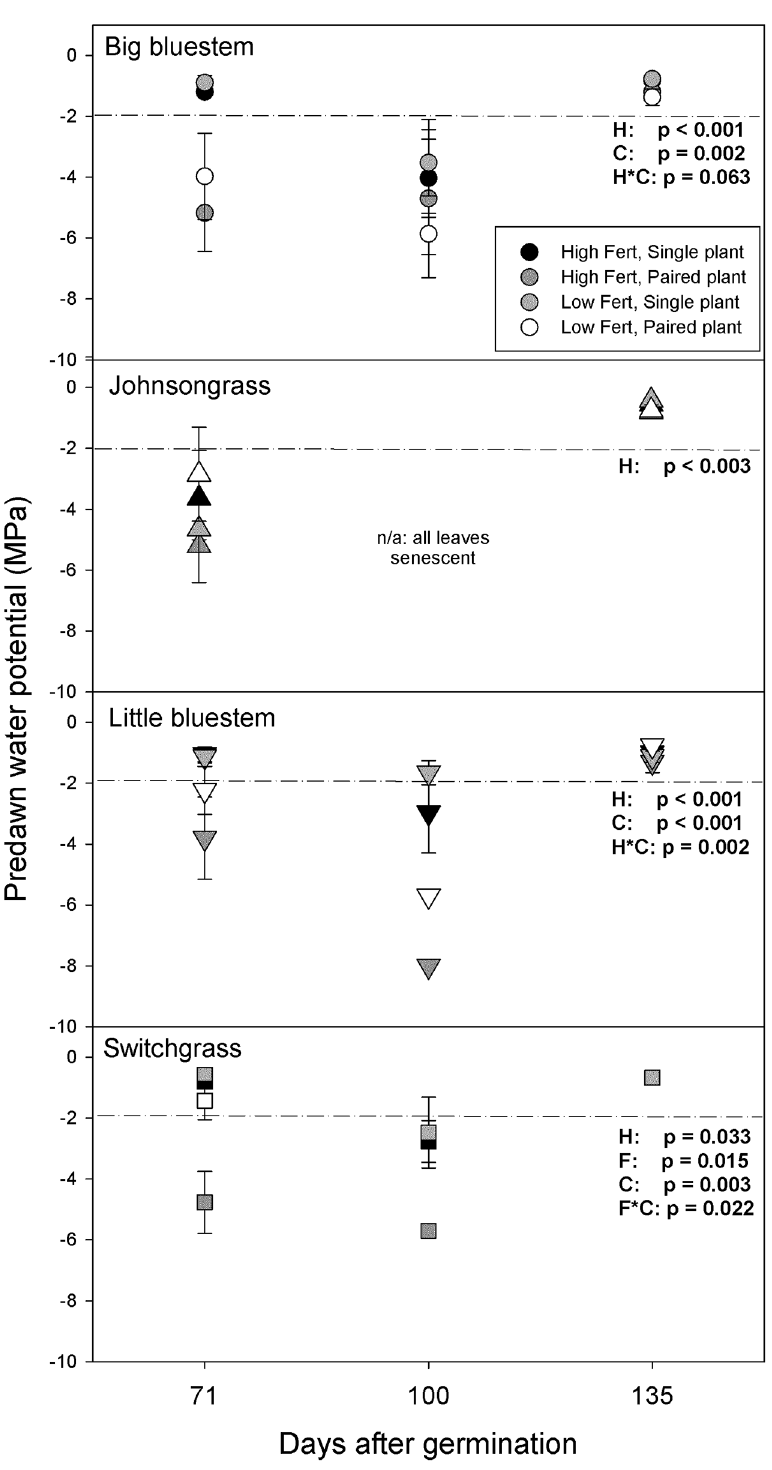
Fig 5. Predawn water potentials at approximately the mid-point (day 71) and the end (day 100) of the dry-down period and 35 days after resuming the watering regime (day 135). Error bars reflect one standarderror of the mean. The p-values of statistically significantor marginallysignificanteffects are summarized by species in each panel. Letter symbols stand for the effects of harvest date (H), fertilizer (F), competition(C) and their interactions(H * C, F * C). Where there is no error bar only one measurement